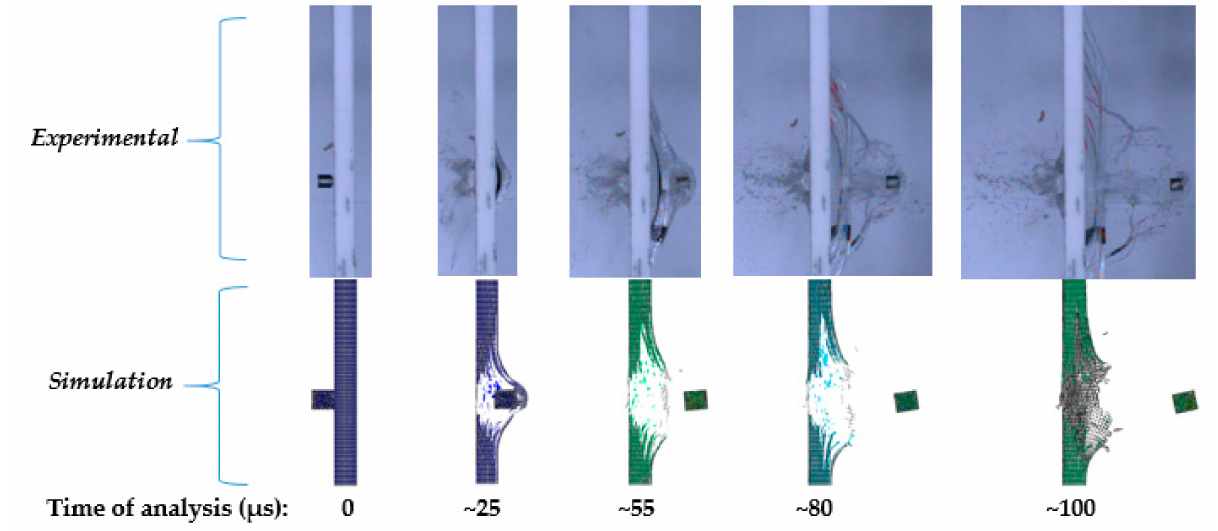
Figure 12. Sequential time steps after the ballistic impact, Vinitial = 893 m/s.